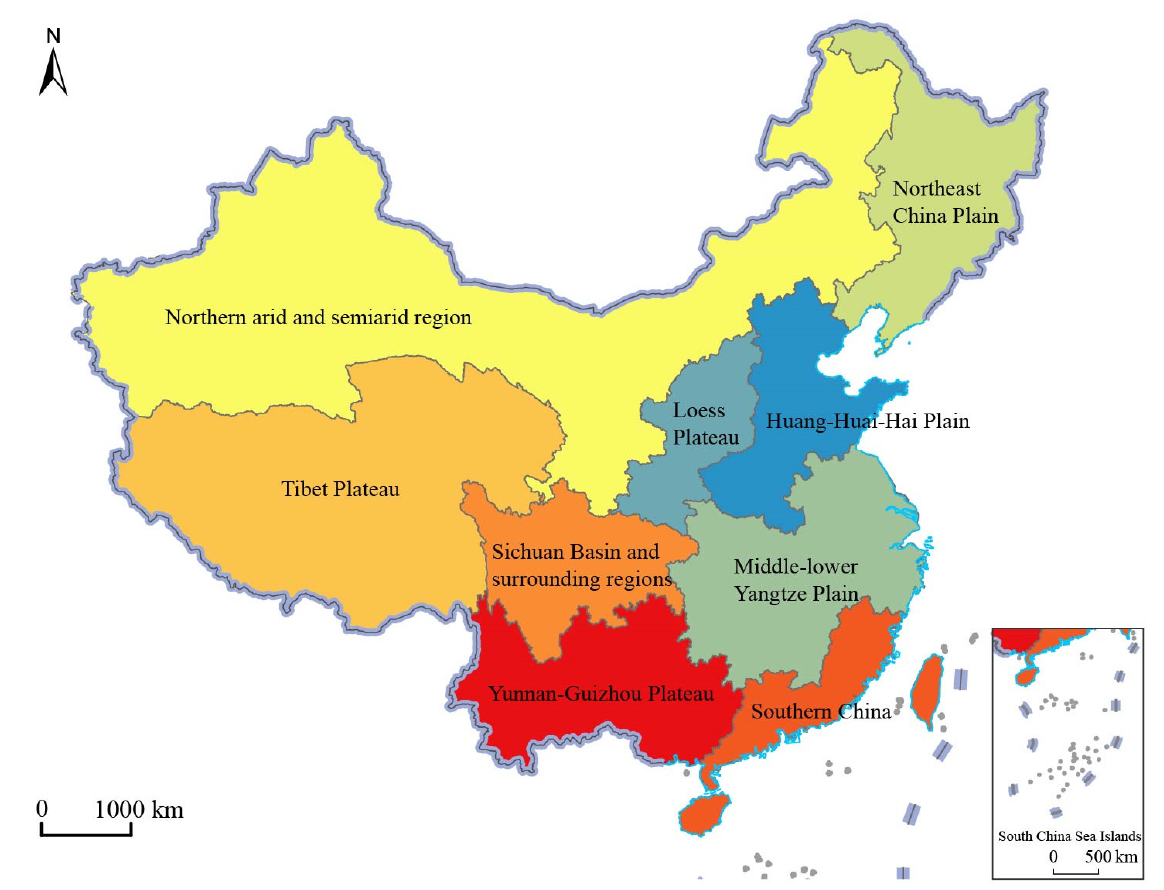
Figure 1. Nine Agricultural Areas of